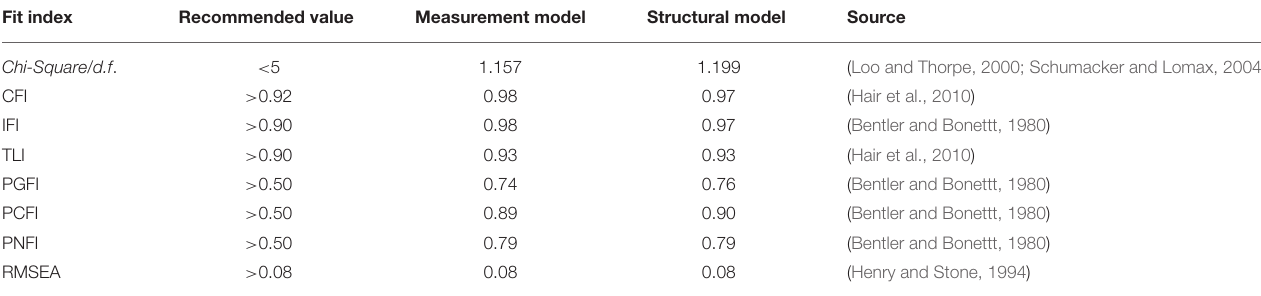
TABLE 4 | Goodness-of-fit indices for the measurement